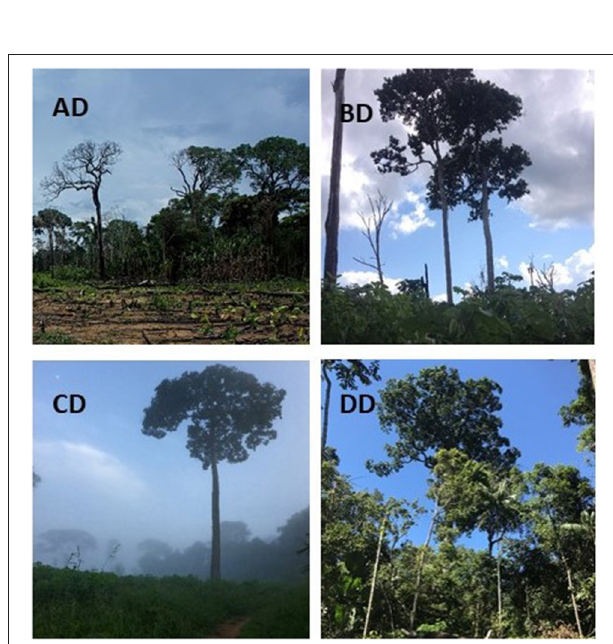
FIGURE 2 | Photos of the four degraded forest sites ( AD , BD , CD , and DD ). Note that heterogeneity within sites was large (see Figure 3 ), and photos are therefore not representative of the entire site. Photos by Gabriela Wiederkehr